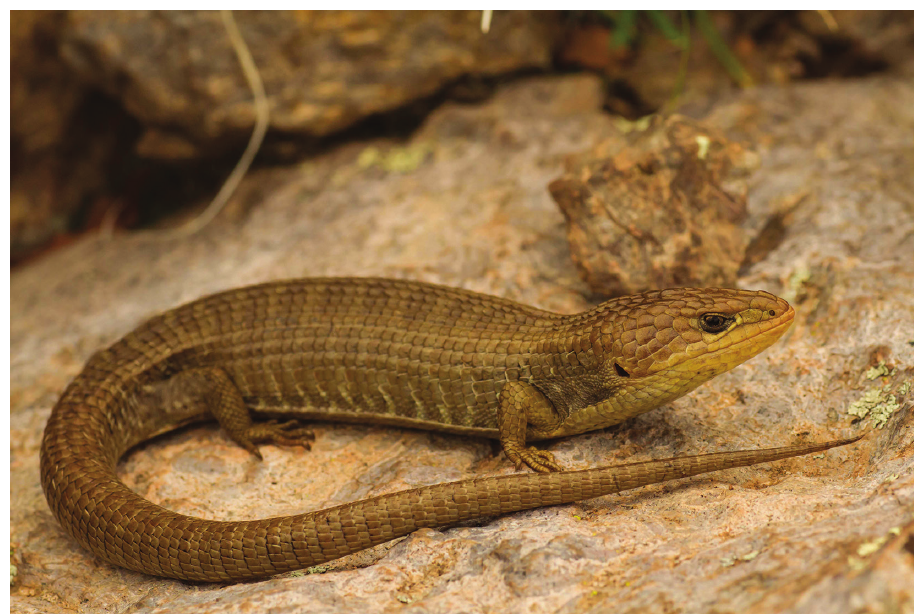
Figure 4. Barisia levicollis (female). Sierra del Nido, Chihuahua. Photo courtesy of Marisa